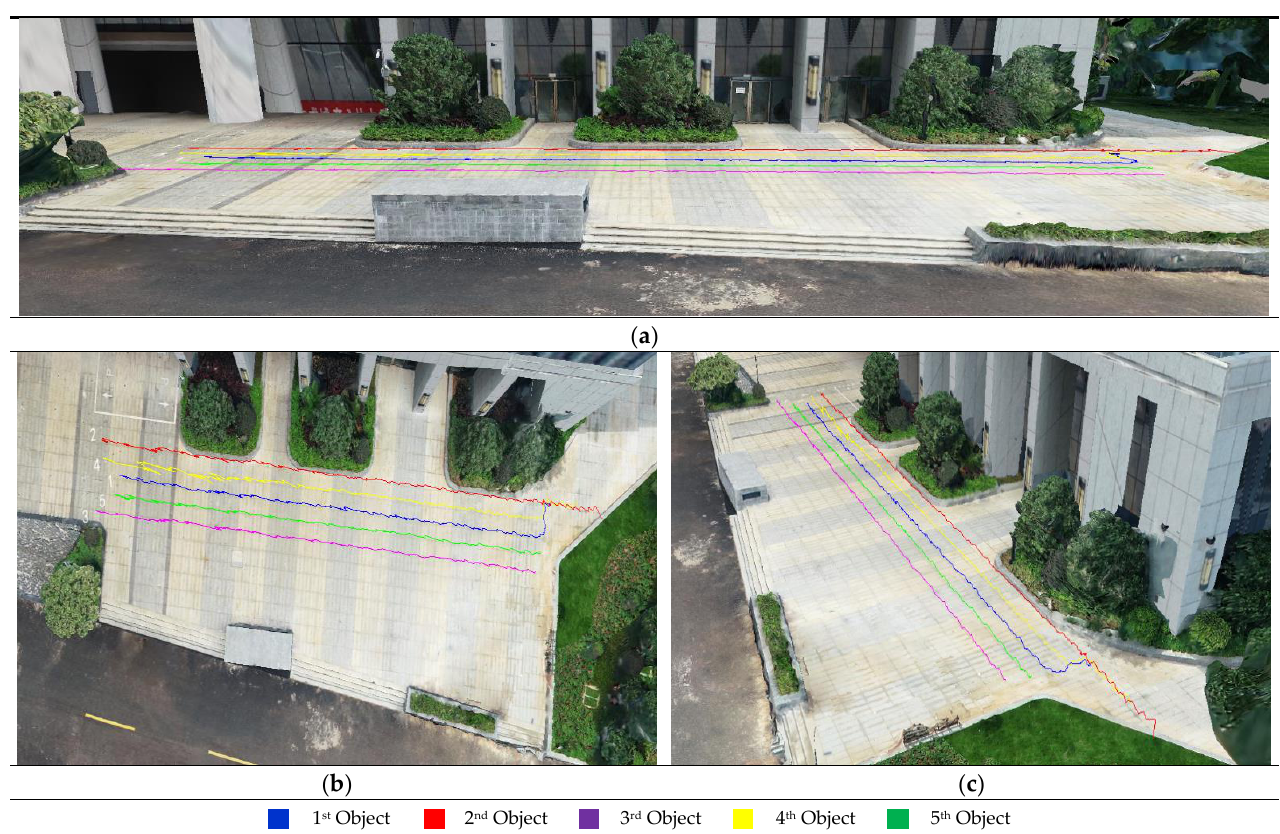
Figure 15. Display of multi-object trajectories in the 3D model from three different views. ( a ) Side view; ( b ) top view; ( c ) roughly the camera’s direction.